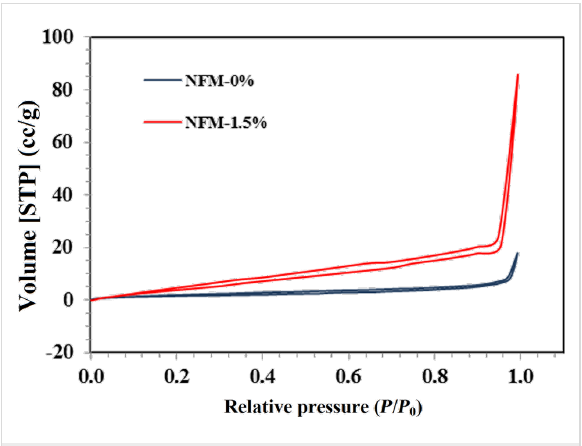
Figure 3: Nitrogen adsorption isotherms at 77 K for NFM-0% and NFM-1.5%.